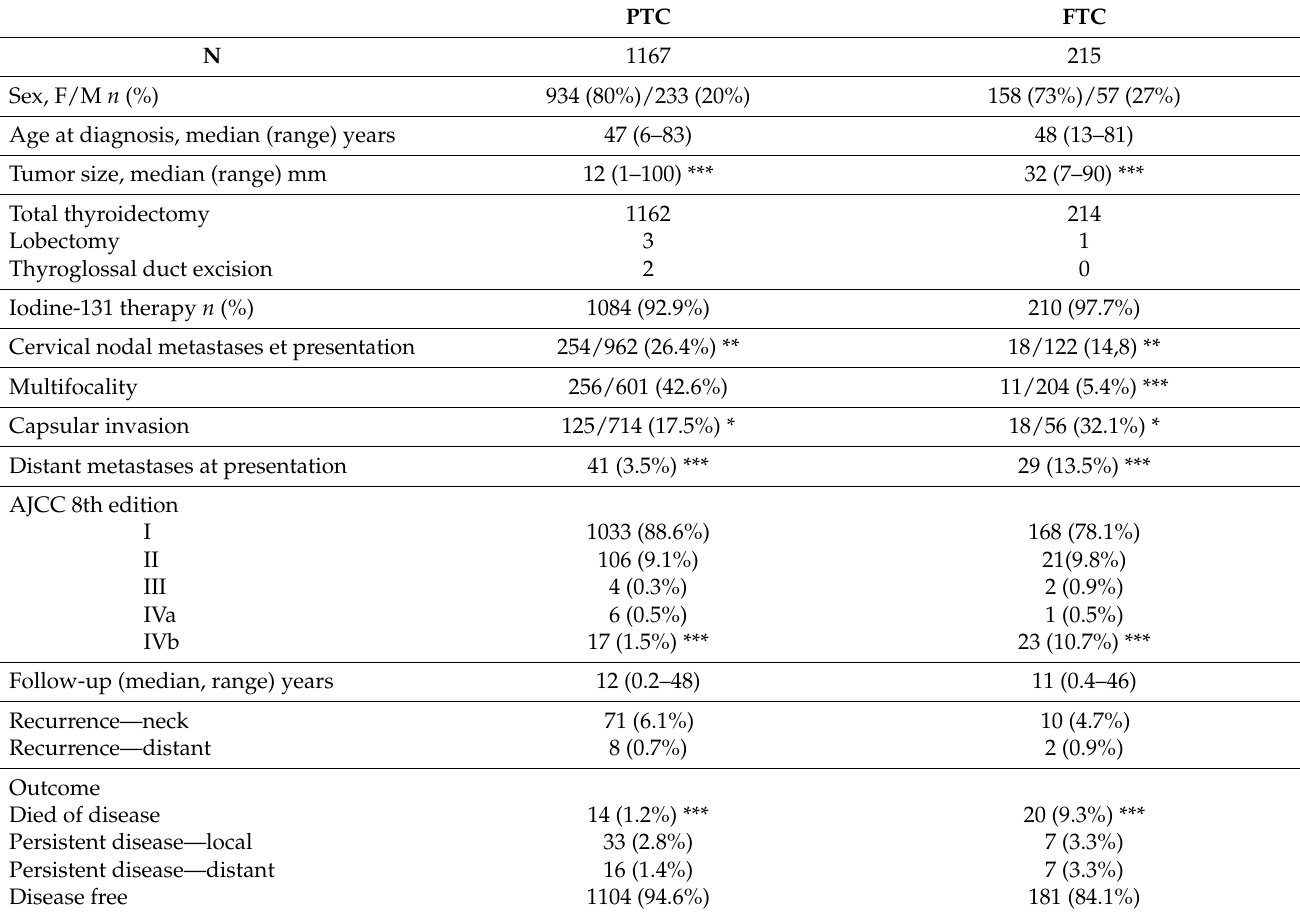
Table 1. Demographic and clinical data of 1382 patients treated for differentiated thyroid cancer with analysis of differences between PTC and